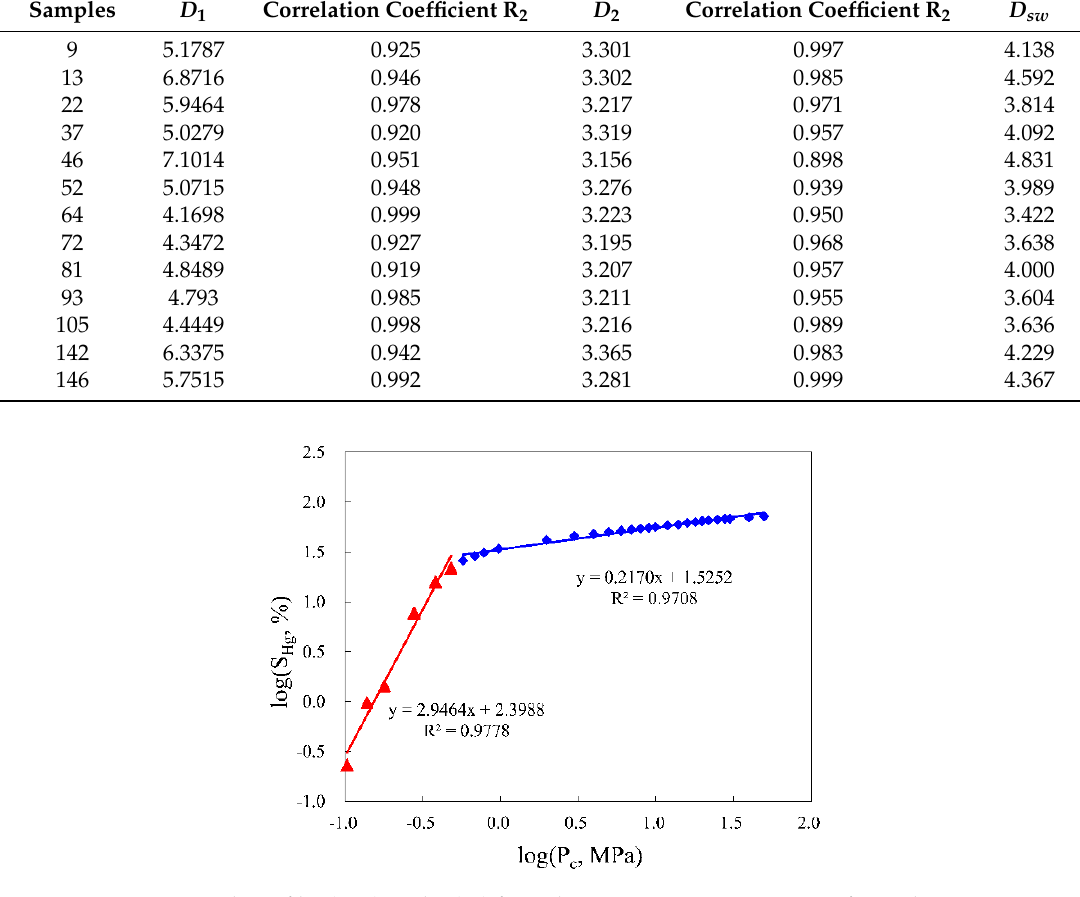
Figure 4. Plot of the sum of fractal dimension D 1 versus r 50 . Table 2. Parameters of the fractal dimension obtained from the 13 samples.